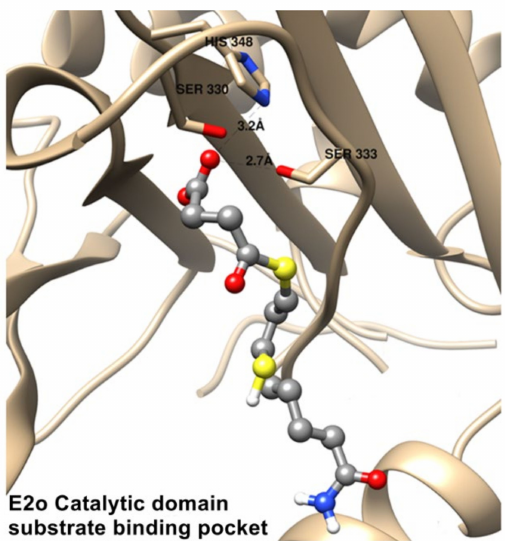
Figure 6. The succinyl-binding site of the E. coli E2o catalytic domain with succinyldihydrolipoamide modeled into it [110]. The succinyl-binding site contains residues Ser330 and Ser333 within hydrogen- bonding distance of the carboxylate group of succinyldihydrolipoamide. The His348 which may be responsible for substrate recognition is shown. The modeling was performed by using UCSF Chimera Autodock program [111] and coordinates of the E. coli E2o catalytic domain deposited under the accession number 1C4T